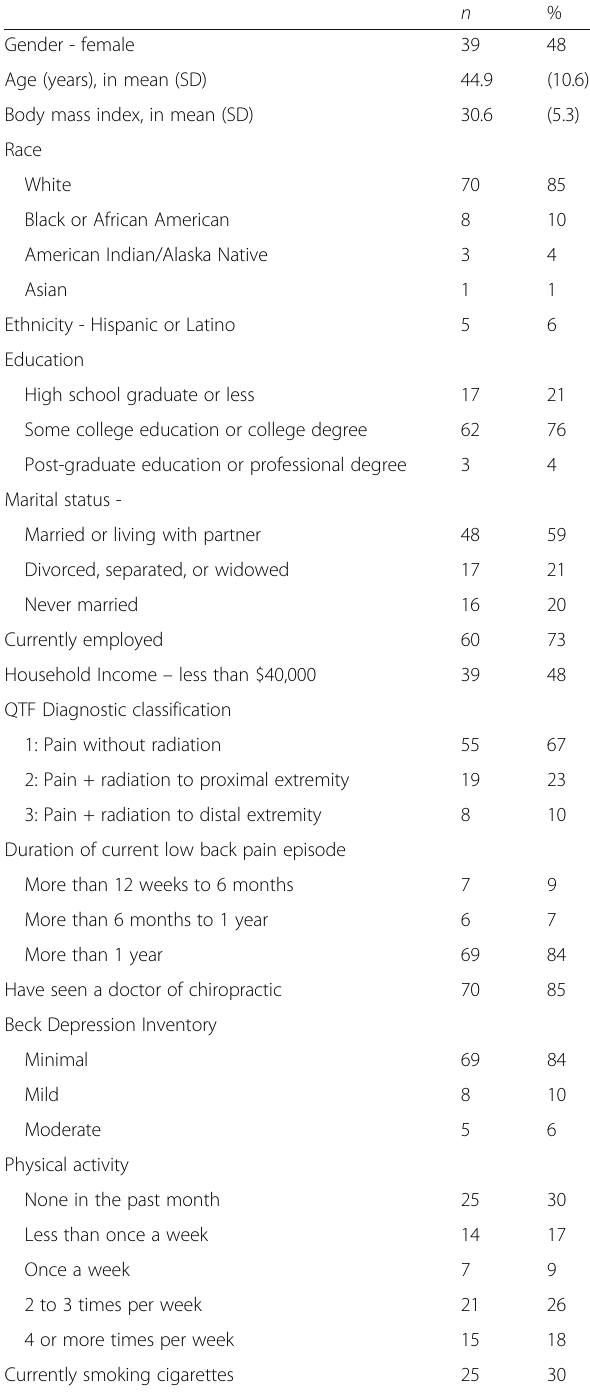
Table 1 Descriptive statistics of selected demographic